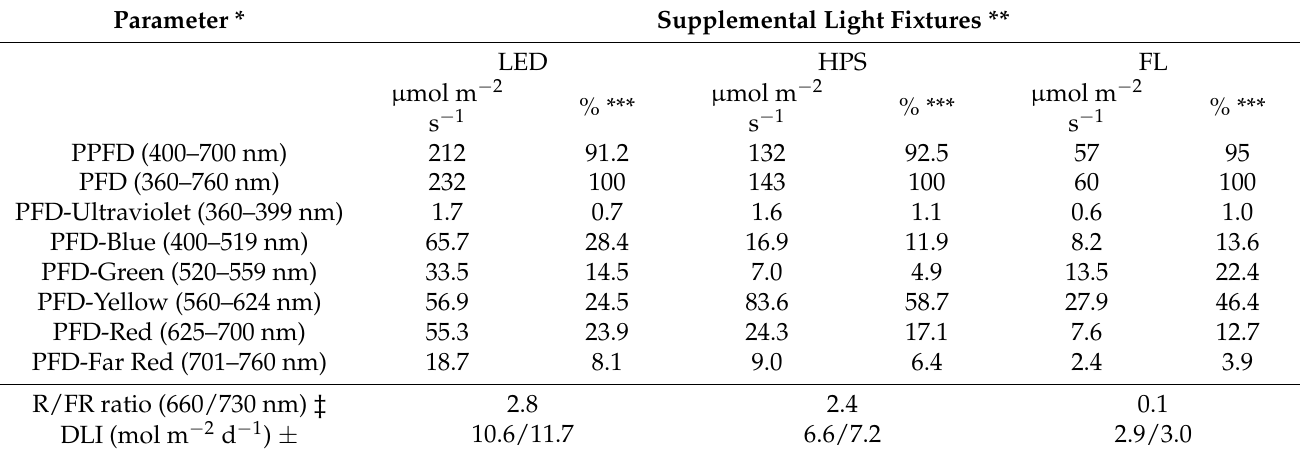
Table 1. Spectral composition of the supplemental lighting fixtures used in the greenhouse for the cultivation of thyme ( Thymus vulgaris